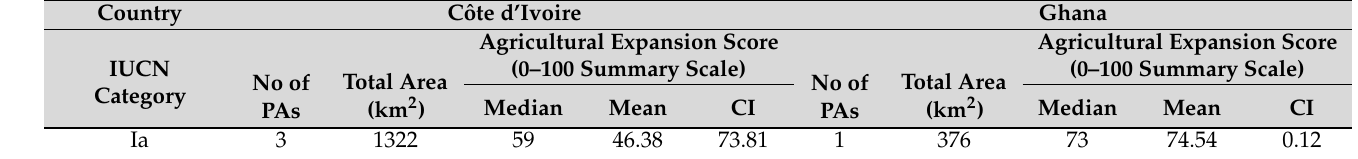
Table 9. Summary statistics (median, mean, and CI for mean value) for the future development threat of agricultural expansion in C ô te d’Ivoire and Ghana’s protected areas (IUCN PA categories, those without assigned categorizations (not reported) and World Heritage Sites or UNESCO MAB reserves (not